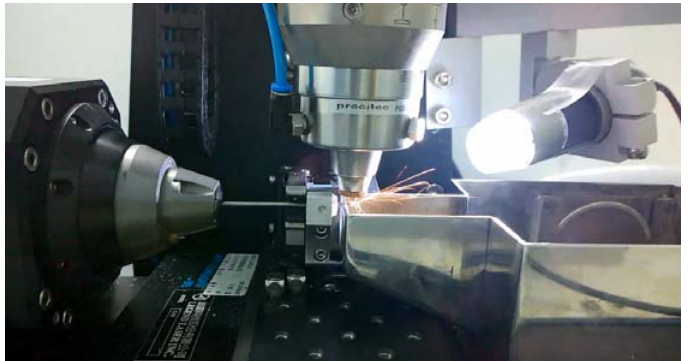
Figure 5. Cutting the design pattern of the rhombic ‐ shaped channel stent onto a hypotube by